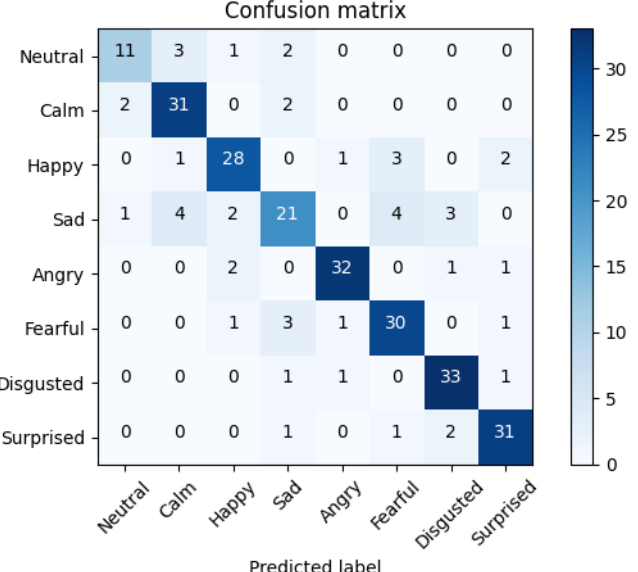
Figure 5. Average confusion matrix of the fine-tuned CNN-14 experiment with an accuracy of